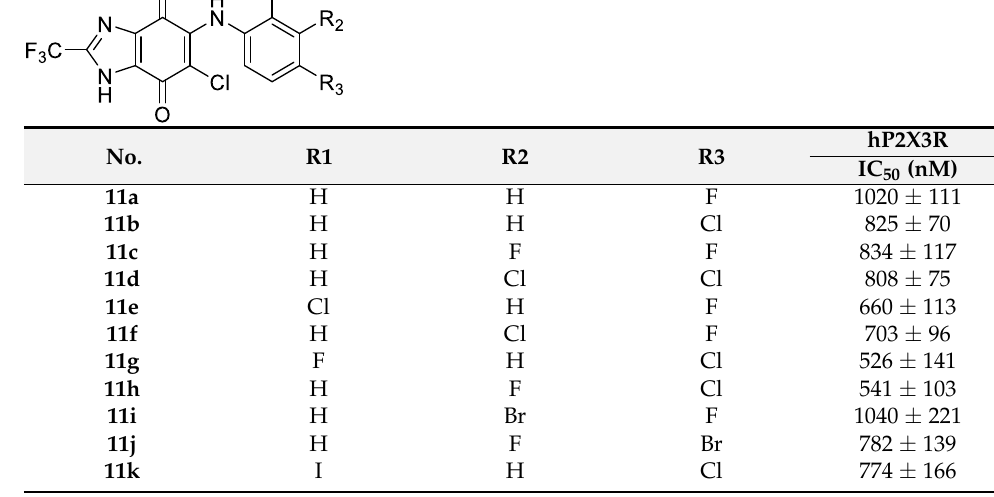
Table 2. The antagonistic activity profile of halide-substituted aniline derivatives.